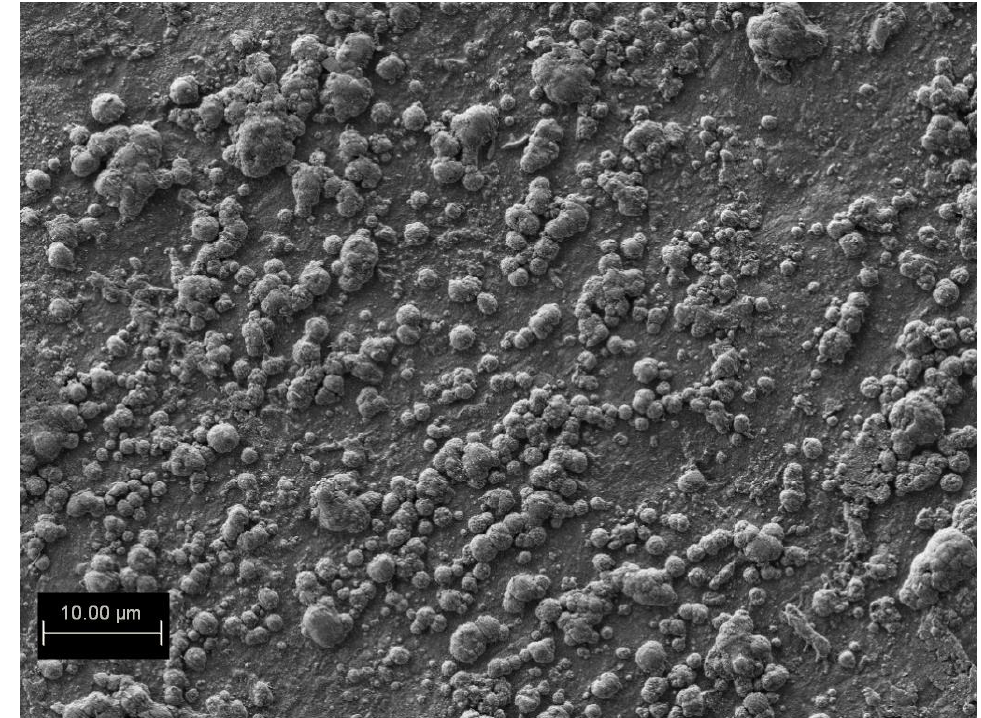
Figure 3. SEM image of the Gr/Ge/Si(001) surface after 150 h of water vapor treatment.